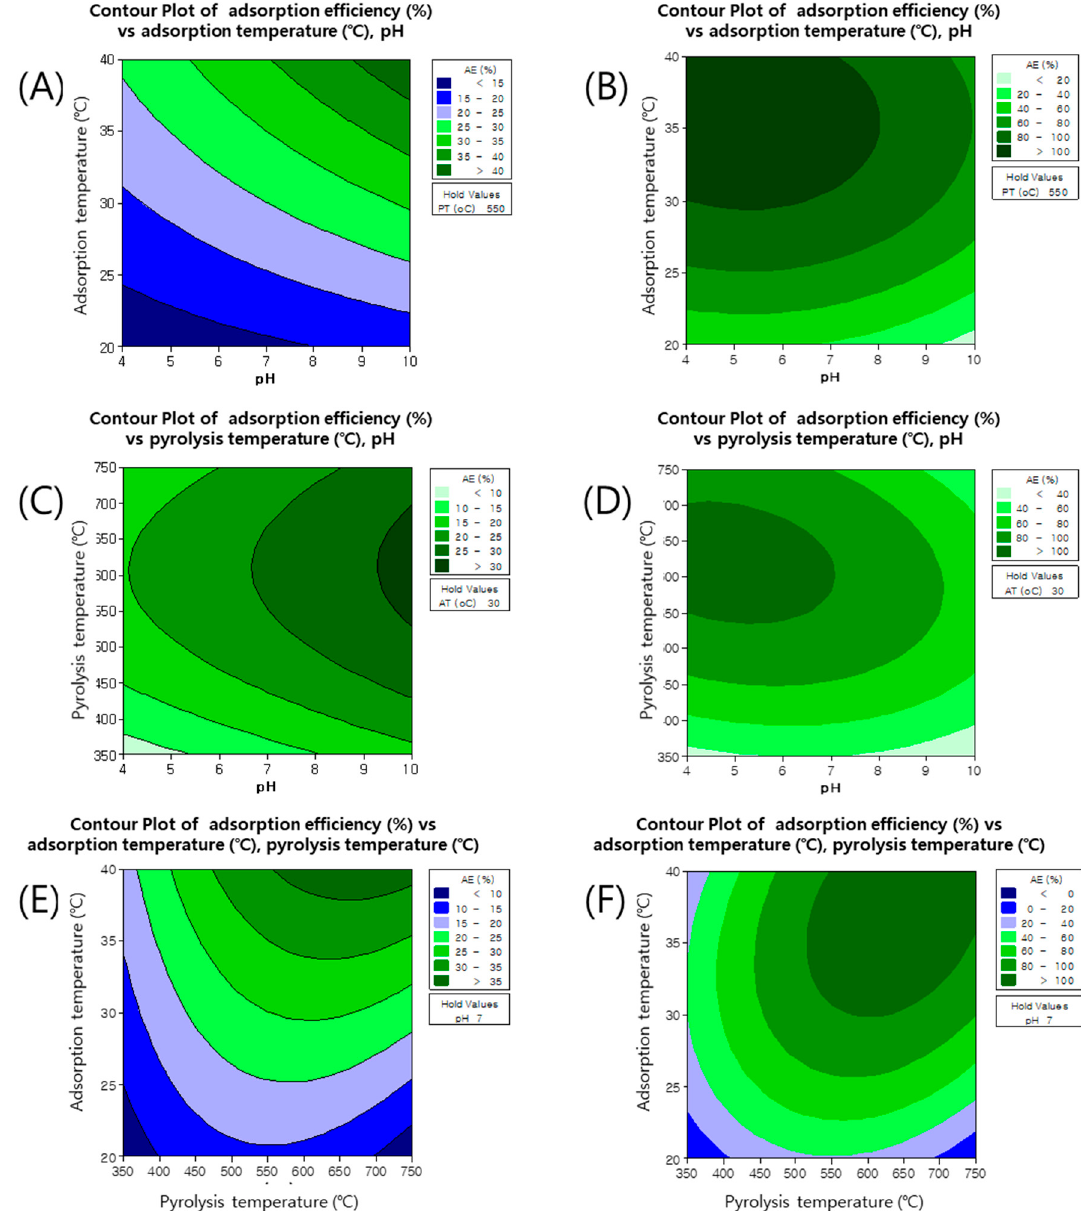
Figure 1. Two-dimensional contour plots showing effects of pH, pyrolysis temperature (PT, °C), and adsorption temperature (AT, °C) on adsorption efficiency of methylene blue (MB) ( A , C , and E ) and congo red (CR) ( B , D , and F ).